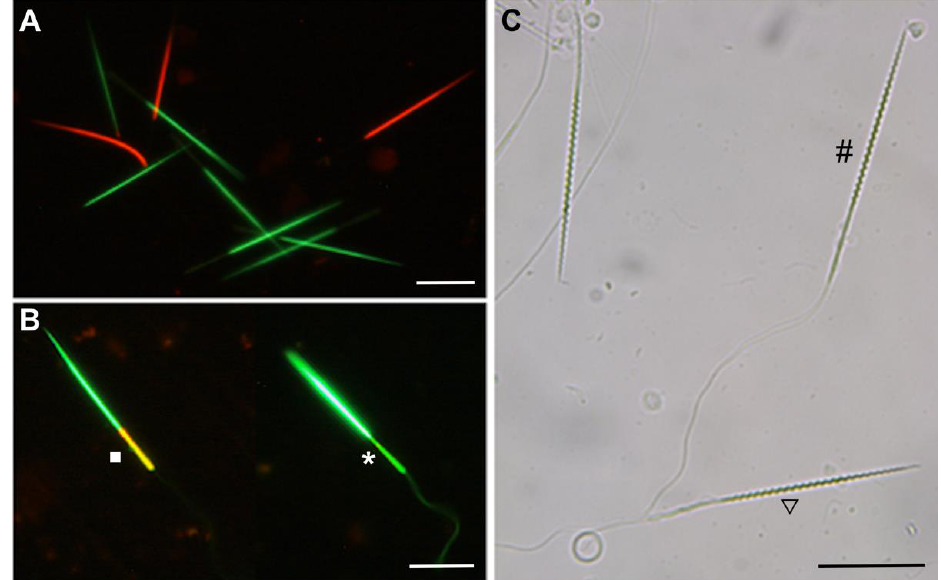
Figure 2. Representative images of small-spotted catshark ( Scyliorhinus canicula ) sperm cell quality. Scale bar, 20 μm. ( A ) Epifluorescence micrographs of sperm cells stained with SYBR-14 (green) and propidium iodide (red) at 200× magnification. Green fluorescence shows live sperm, and red fluorescent indicates dead sperm. ( B ) Epifluorescence micrographs of sperm cells stained with JC-1 at 200× magnification. The dye changes emission wavelength depending on membrane potential by a shift from orange, showing high potential (square), to green color, showing low potential (asterisk). ( C ) Phase-contrast image displaying tail swelling to assess the functional integrity of membrane by hypoosmotic swelling test at 200× magnification. Coiled tail spermatozoa were identified as having a functional intact plasma membrane (triangle); normal tail spermatozoa were identified as having a nonfunctional intact plasma membrane (octothorpe).